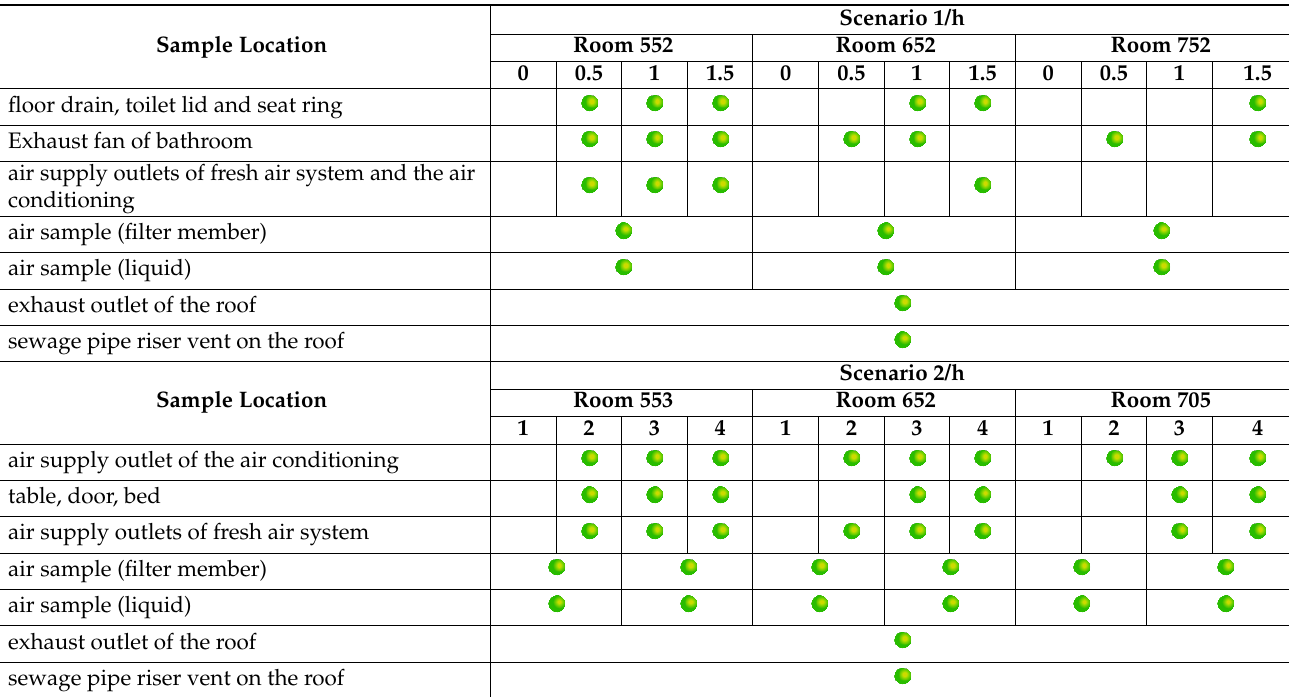
Table 1. The detection results of fluorescent microspheres of swab samples and air samples collected in different locations of different rooms in different time.